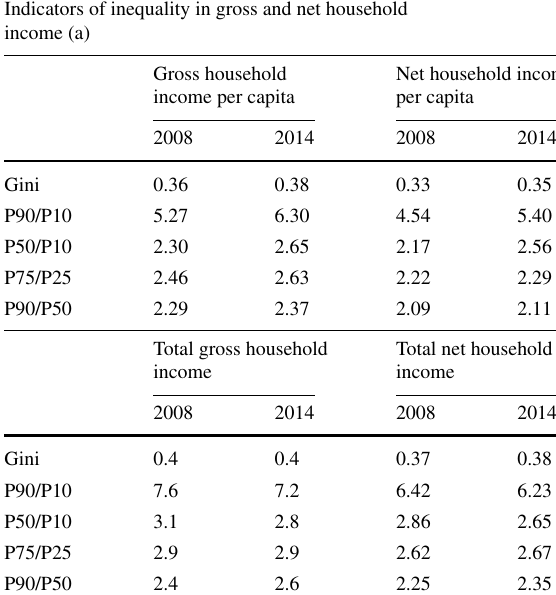
Table 9 Indicators of earnings and income inequality during the recovery period. Source : INE (Spanish Labour Force Survey and Survey of Income and Living Conditions)